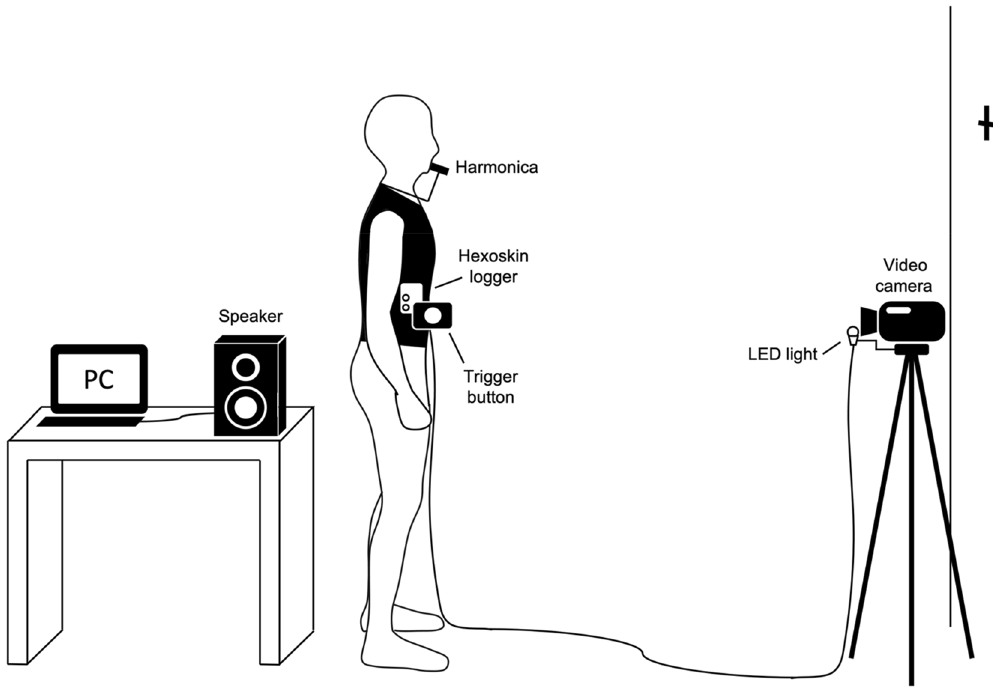
Figure 5. Experimental setup. Participants breathed via a harmonica while looking at a fixed point on the wall from a distance of 2 m. The thoracic and abdominal movements during breathing were measured using a Hexoskin vest equipped with two strain gauge bands around the chest and waist and an electrocardiogram sensor. The data was stored in a logger equipped with a 3-axis accelerometer. The metronome beats were presented via a speaker from a laptop. The sounds of the harmonica and metronome beats were recorded using a video camera. The Hexoskin data and video recordings were synchronized by hitting a trigger button that illuminated a light-emitting diode in the view of the video camera. The participants pressed the button on a Hexoskin logger with the accelerometer at the beginning of each